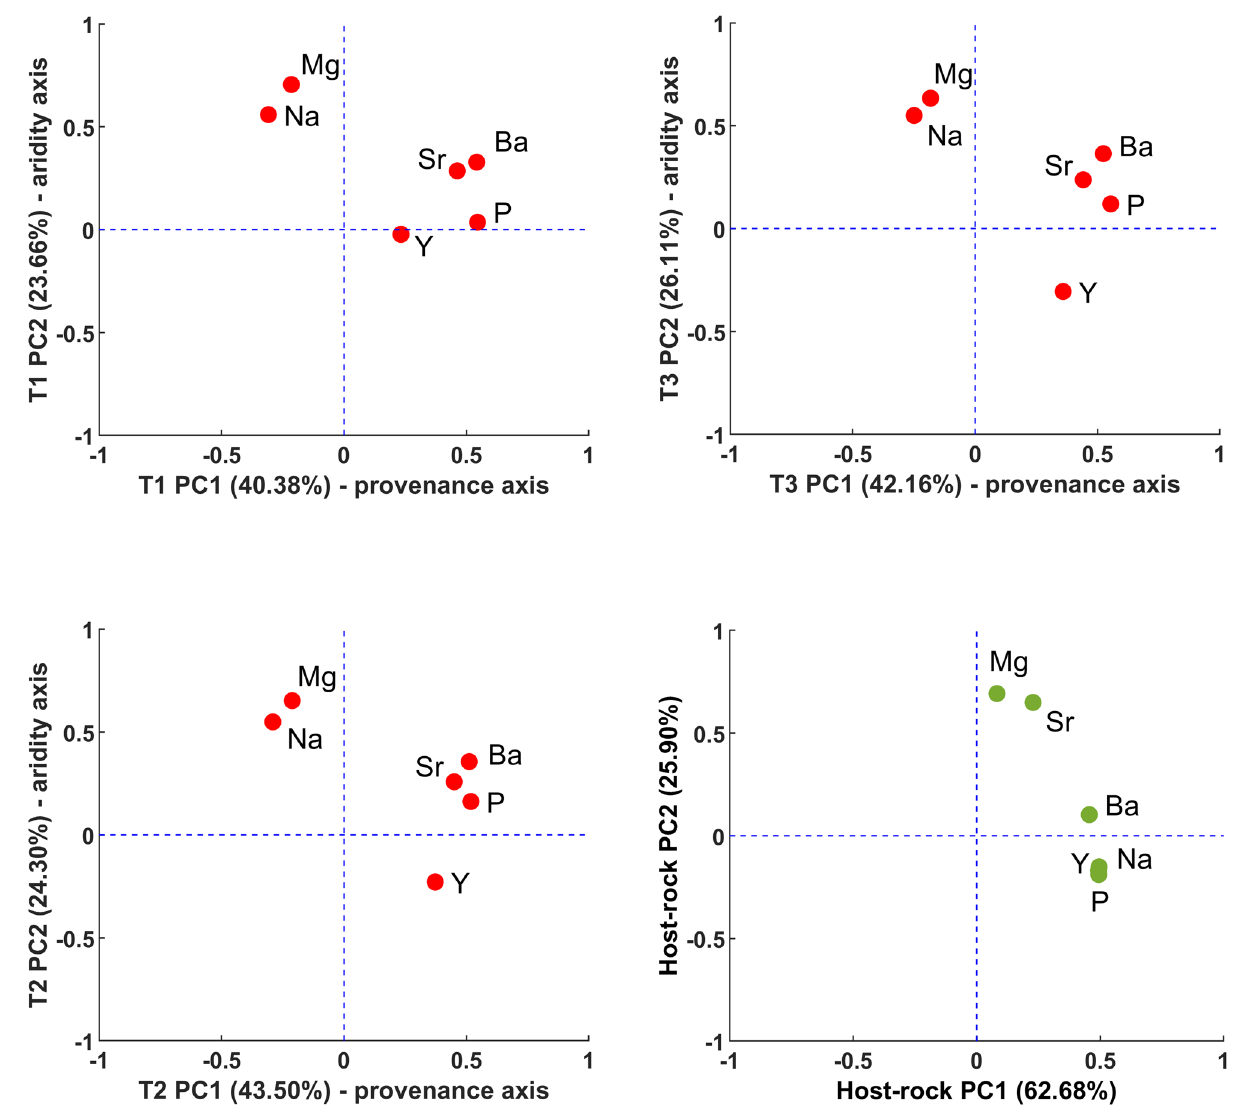
Figure 2. Loadings of different elements in PCA-A on stalagmite trace elements measured at three transects (plots with red markers), and on host-rock trace elements (plot with green